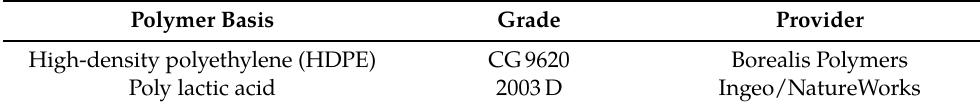
Table 1. Polymers for preparing antibacterial multifilament fibres. Polymer